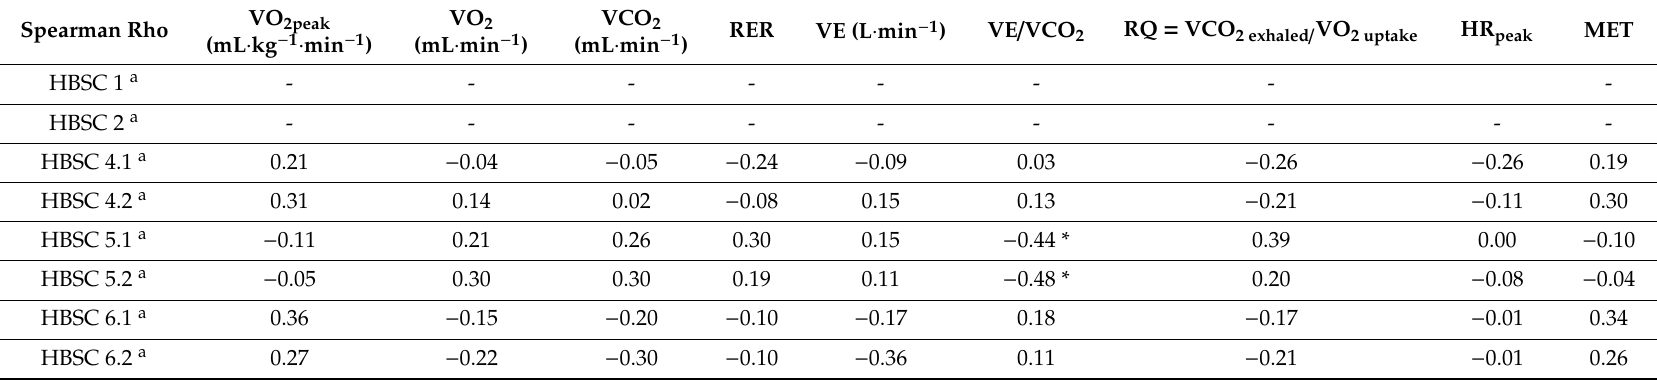
Table 12. Correlation between the survey results that assessed the level of physical activity and sedentary behaviors and the results of the exercise stress test in the study group of children in total. Values of p < 0.05 were considered statistically significant. a The question content of the HBSC questionnaire is presented in Table 7. Spearman Rho